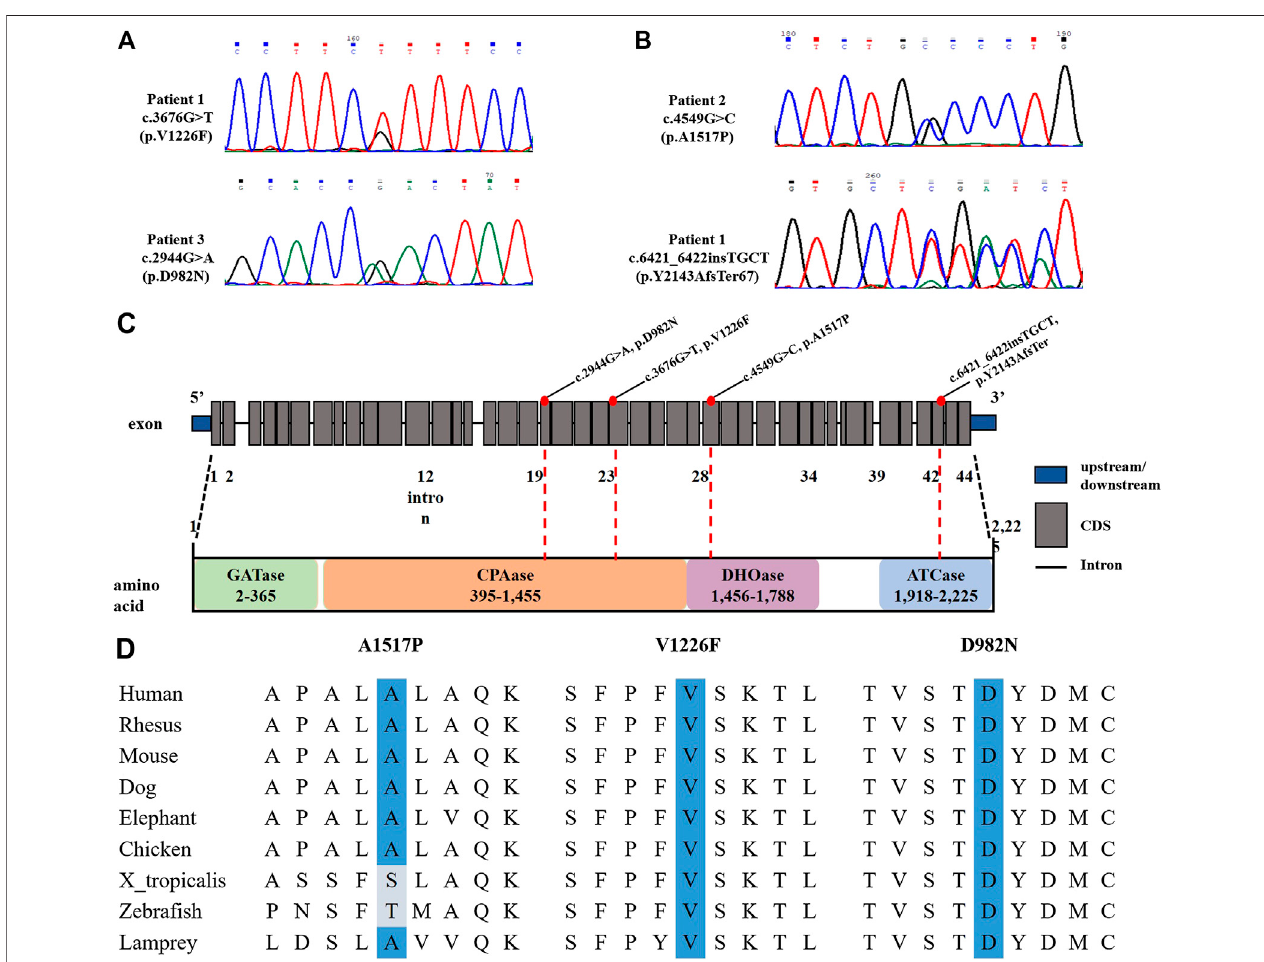
FIGURE 3 | Gene results of two patients with CAD de fi ciency. (A , B) Sanger sequencing of our two cases demonstrated CAD compound heterozygous variants. (C) Location of CAD variants. (D) Evolutionary conservations of the missense mutations (A1517, V1226, and D982).